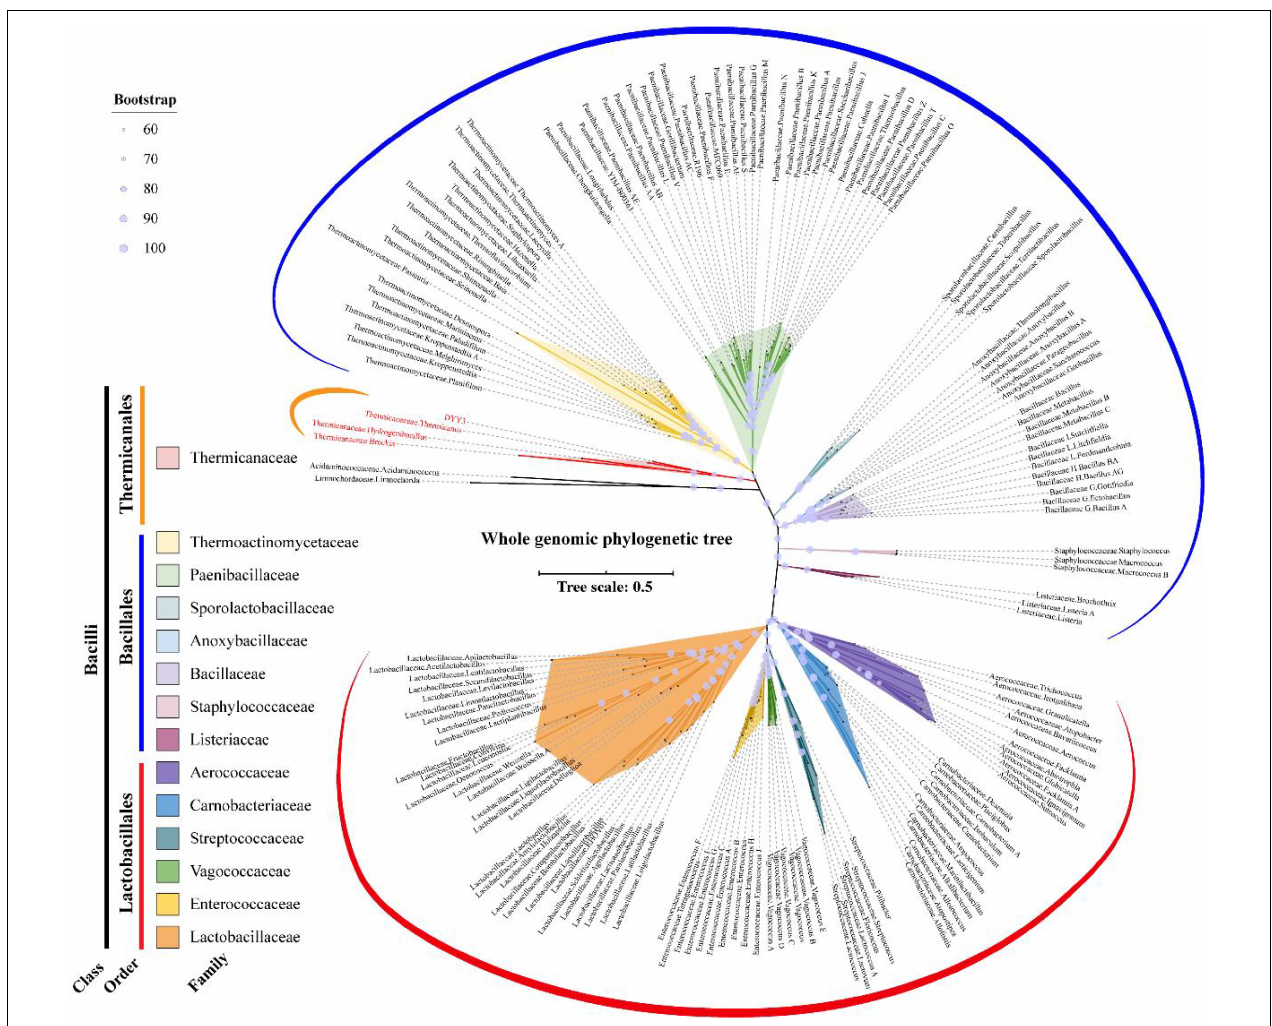
FIGURE 4 | Whole genome-based phylogenetic relationship of strain DYY3. The unrooted whole genomic maximum likelihood tree was constructed by IQ-TREE using GTDB-based 120 conserved core genes with a bootstrap value of 1,000. Acidaminococcaceae, Acidaminococcus, Limnochordaceae, and Limnochorda were set as the out-group, and the other species were Bacilli in class. The 14 families of the Bacilli class were differently colored, and the bootstrap values for each node were shown by the size of a light blue